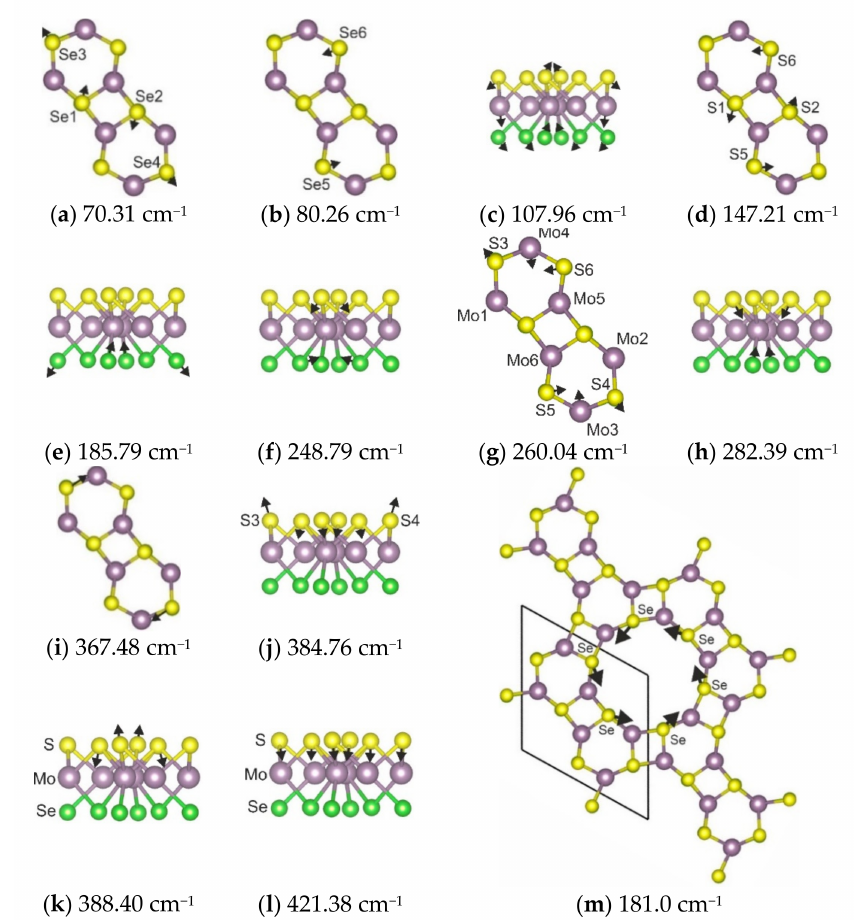
Figure 9. Eigenmodes of 1H’ MoSSe selected vibrations. The spectral profile of the 1H’ phase contains strong peaks at 80 cm − 1 and medium peaks at 70, 147, 185, and 248 cm − 1 . Several weak bands are observed at 108, 260, 282, 364, and 386 cm − 1 . The medium band at 70 cm − 1 is an in-plane Se translation, shown in Figure 9a. The strong band at 80 cm − 1 is also related to in-plane Se vibrations (Figure